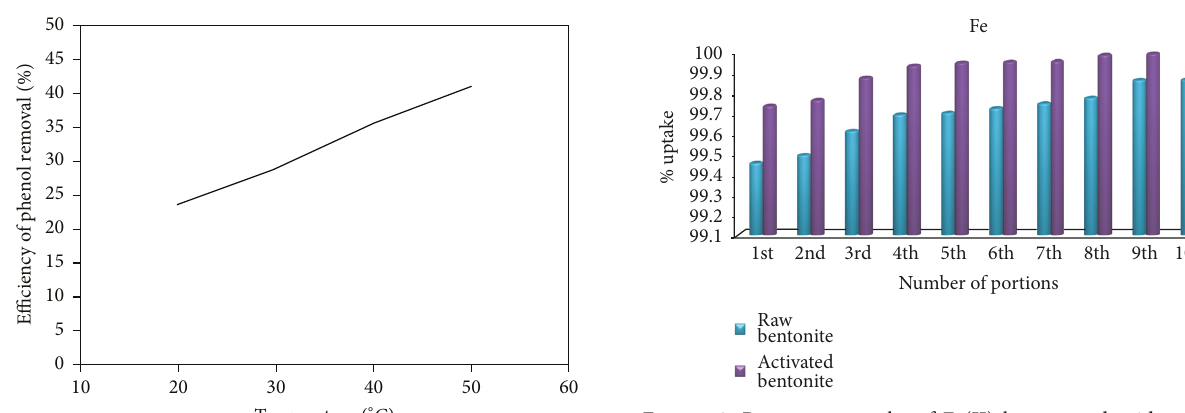
Figure 8: Percentage uptake of Fe(II) by raw and acid activated bentonite using column technique.